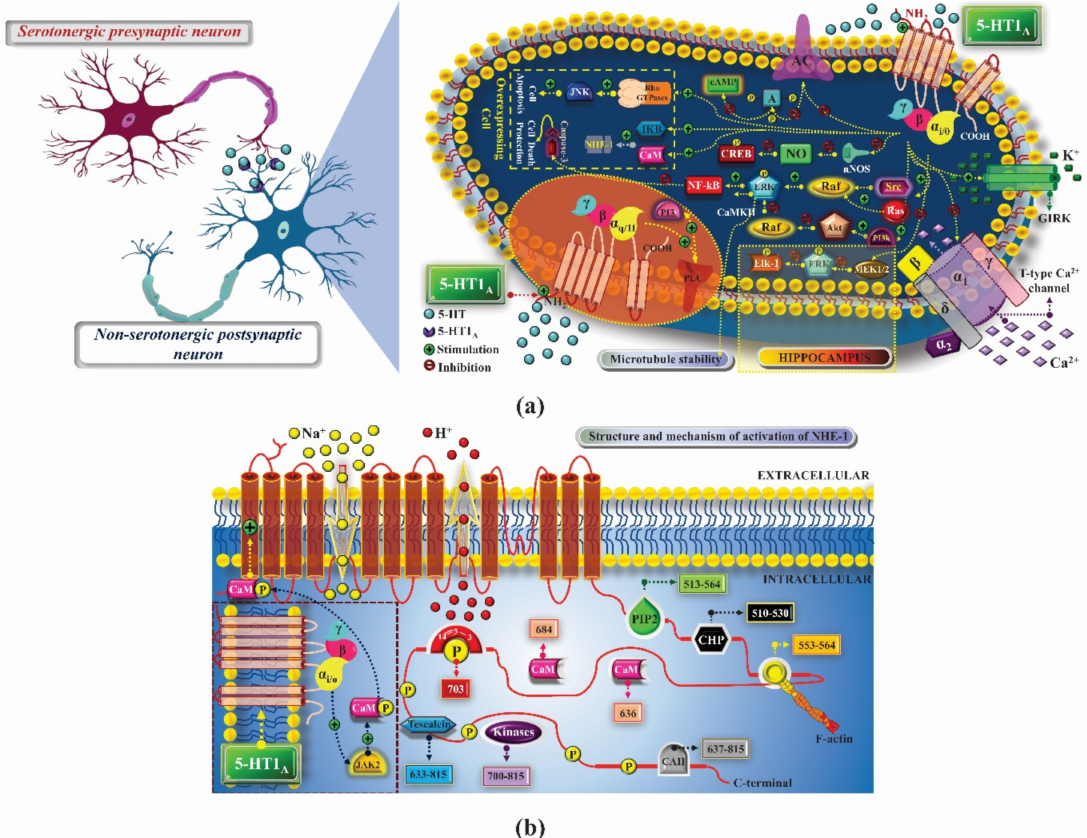
Figure 1. Serotonin (5-HT 1A ) receptor signaling pathways: ( a ) The 5-HT 1A receptor is coupled to the G α i/0 protein. Its activation blocks the adenylate cyclase activity (AC), reducing the conversion of adenosine triphosphate (ATP) into cyclic adenosine monophosphate (cAMP), which is responsible for the activation of protein kinase A (PKA). The activation of these receptors decreases the release of neurotransmitters in neurons through opposite changes in K + (increase) and Ca 2+ (decrease) conductances. In addition, stimulation of the 5-HT 1A receptor regulates the phosphorylation of the extracellular signal-regulated kinase (ERK). The “atypical” coupling is represented by the orange circle and demonstrates the overexpressing cell Jurkat T-like cell line. The yellow rectangle represents a specific effect on the rat hippocampus, where stimulation of the 5-HT1A receptor reduced MEK1/2 and ERK and Elk-1 phosphorylation. This change in pERK levels was not seen in the cortex [12]; ( b ) the activation of the 5-HT 1A receptor also induces stimulation of the Janus kinase 2 protein (JAK2), which phosphorylates the calmodulin protein, which in turn is associated with the sodium and hydrogen 1 (NHE-1) transporter, activating it. The massive outlet of protons caused by the 5-HT 1A activation culminates in an increase in intracellular pH. The numbers represent the amino acids (approximate region) of the cytoplasmic domain of the NHE1 transporter in which the other proteins